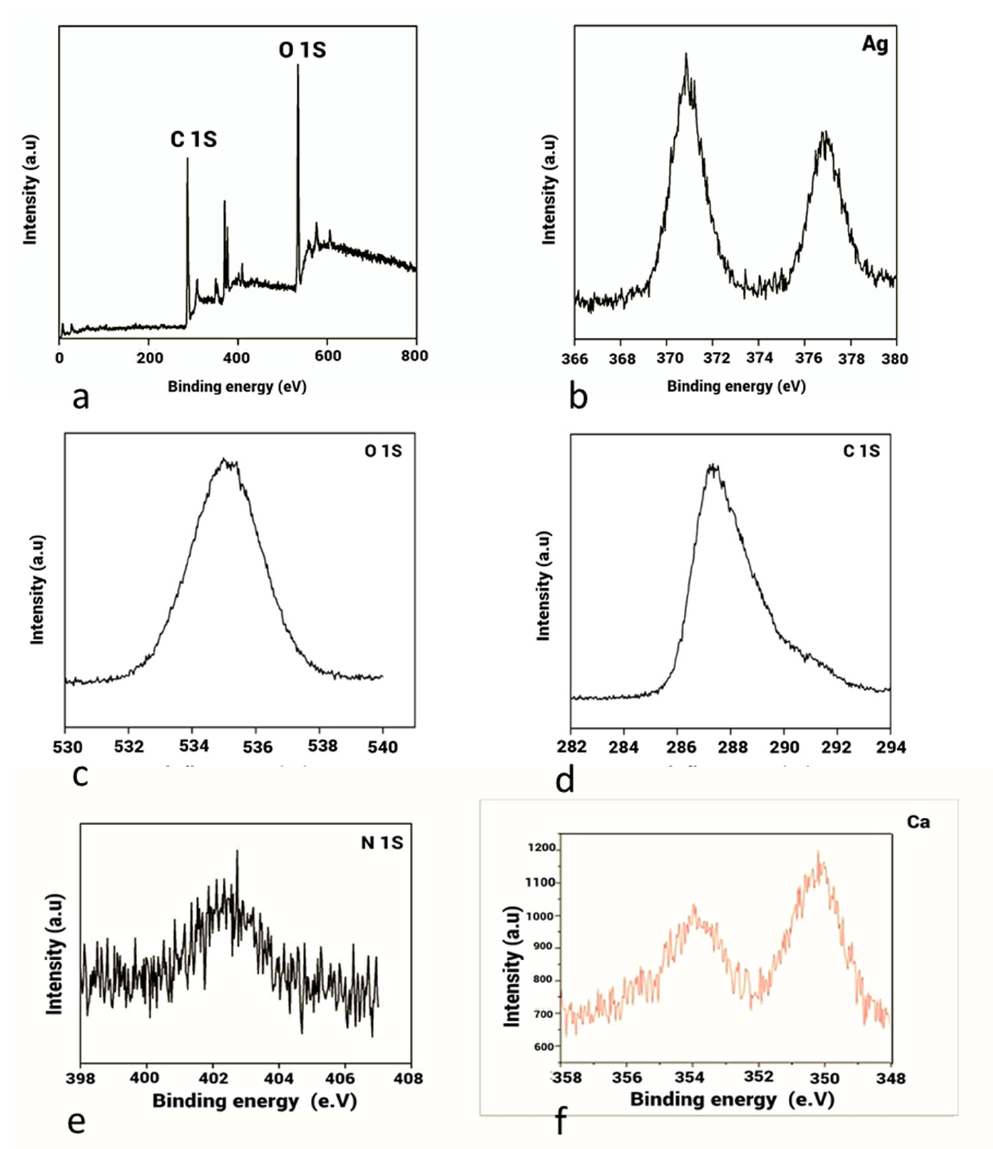
Figure 5. XPS Overall scan ( a ), deconvoluted Ag ( b ), O1s ( c ), C1s ( d ), Ca ( e ), and N1s ( f ) spectra of AC-AgNPs.